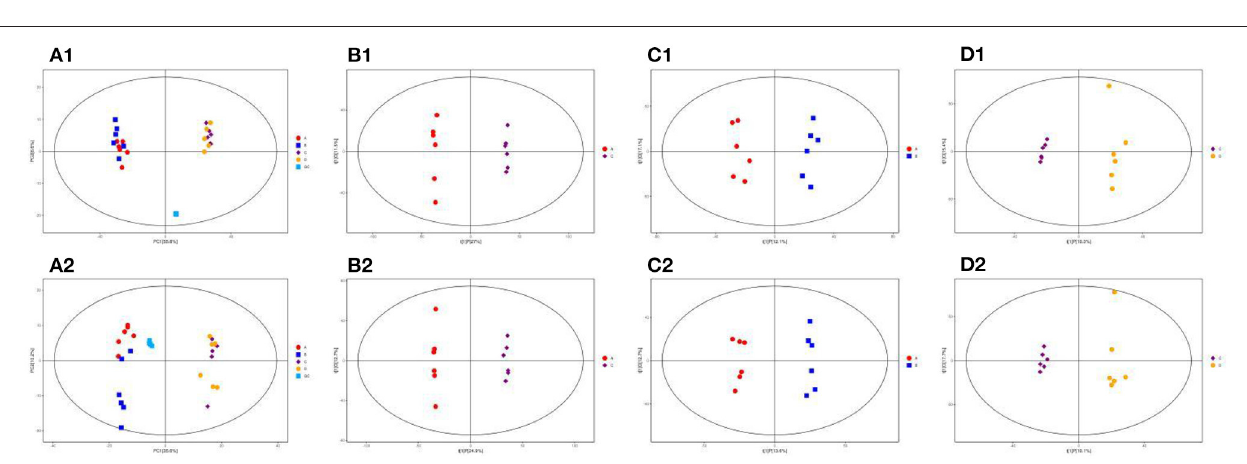
FIGURE 7 | Effects of MBPs on histopathological changes on pancreas stained with H&E [ (A) NCD, (B) NCD + MBPs, (C) HFD, (D) HFD + MBPs]. Magnification, 200 X.